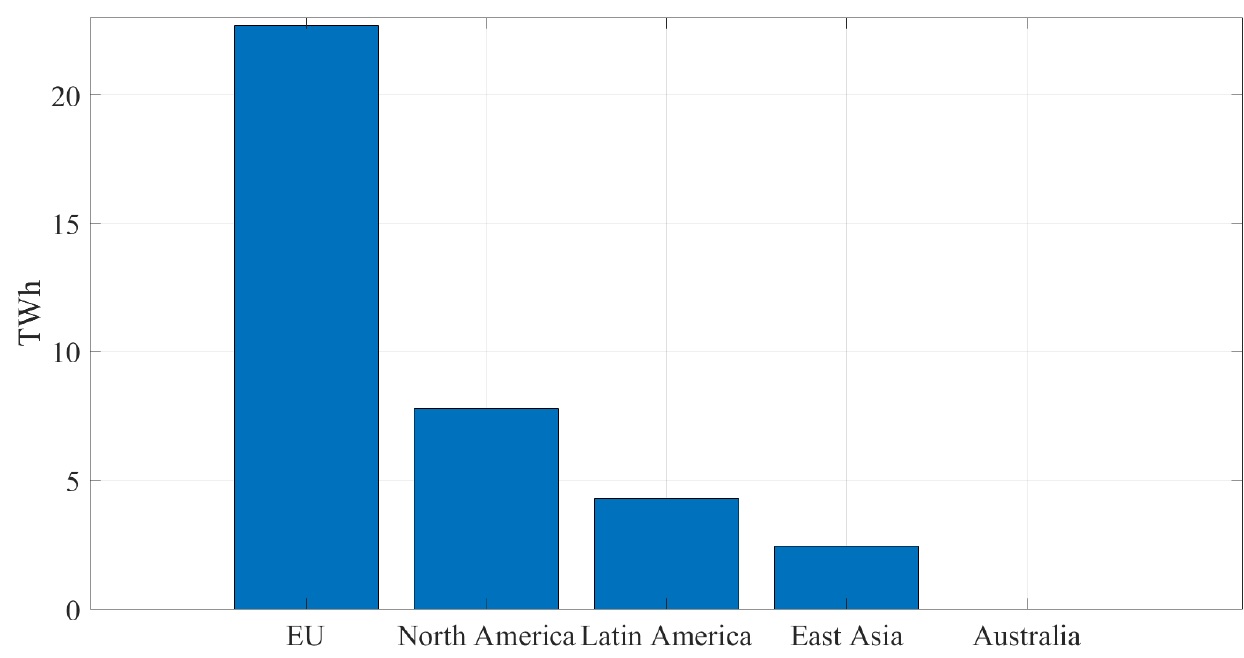
Figure 3. Yearly production of biomethane per geographic area in TWh (2018) .